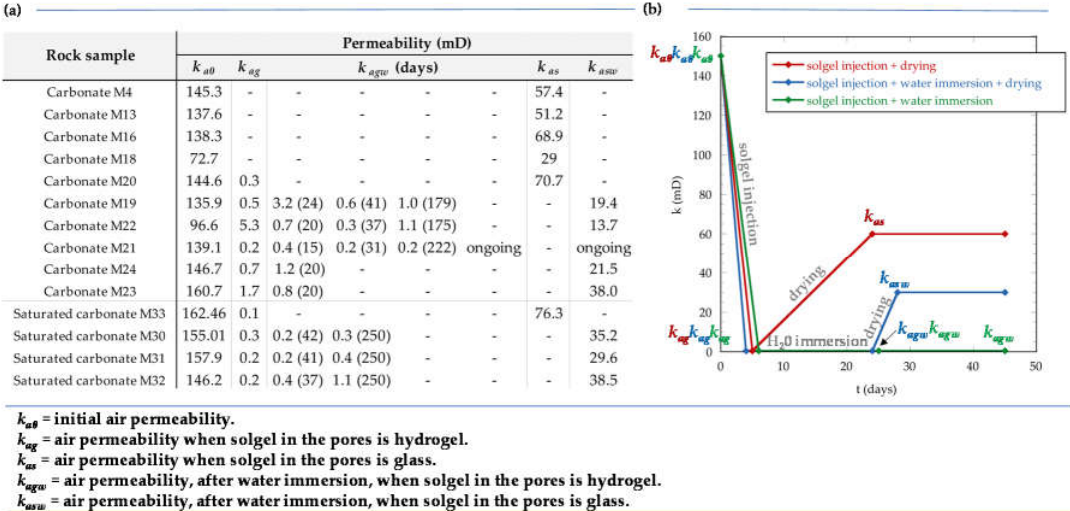
Figure 6. ( a ) Experimental results of the air permeability tests performed with vacuumed and water-saturated reefal carbonate samples; ( b ) scheme showing the experimental results presented in ( a ). k a 0 indicates initial permeability before solgel injection; k ag and k agw denote permeability values measured when solgel inside the porous cores was hydrogel whereas k as and k asw show permeability values measured when solgel inside the porous cores was glass. k agw and k asw values correspond to the permeability measured in samples that were immersed in water before the permeability measurement. Note that the values in brackets shown in the Table indicate the number of days that the core sample was immersed in water before the permeability measurement.